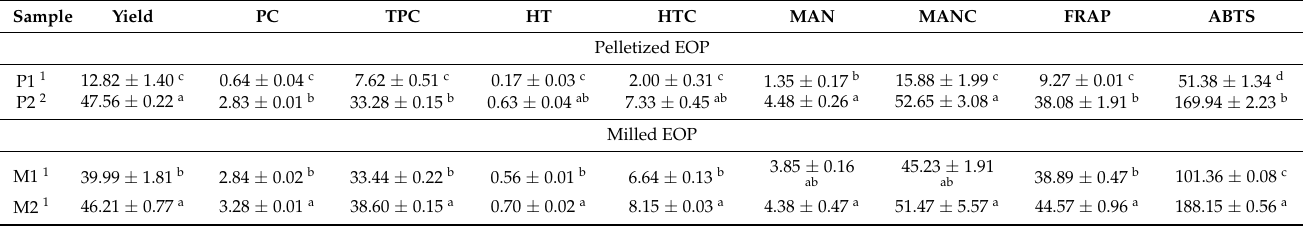
Table 1. Comparison of the application of milling and ultrasound in the extraction of exhausted olive pomace (EOP): yield (%), phenolic concentration (PC) (g gallic acid equivalents/L), total phenolic content (TPC) (mg gallic acid equiva- lents/g dry EOP), hydroxytyrosol concentration (HT) (g/L), hydroxytytrosol content (HTC) (mg/g dry EOP), mannitol concentration (MAN) (g/L), mannitol content (MANC) (mg/g dry EOP) and antioxidant activity (ferric reducing power (FRAP) and ABTS) (mg Trolox equivalents/g dry EOP). Data represent the mean value ± standard deviation ( n ≥ 3). Sample